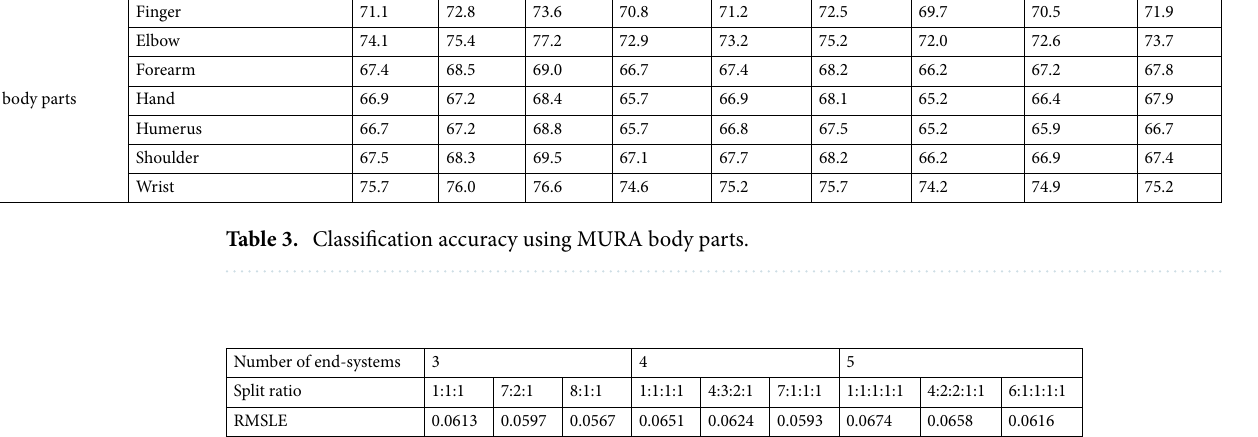
Table 4. The RMSLE loss values for cholesterol data. It shows the loss for each end-system (3, 4, 5 end- systems) with varying